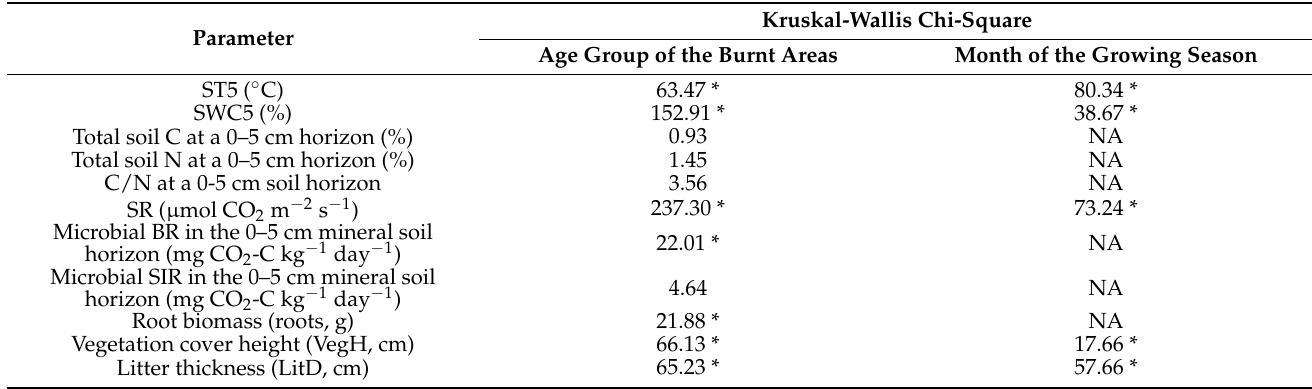
Table 3. Statistical results of the Kruskal-Wallis chi-square test for some physical, chemical, and biological parameters on the study sites during the growing season (June-September), depending on the age group of the sites. ST5, soil temperature; SWC5, soil water content; SR, soil respiration; BR, basal respiration; SIR, substrate-induced